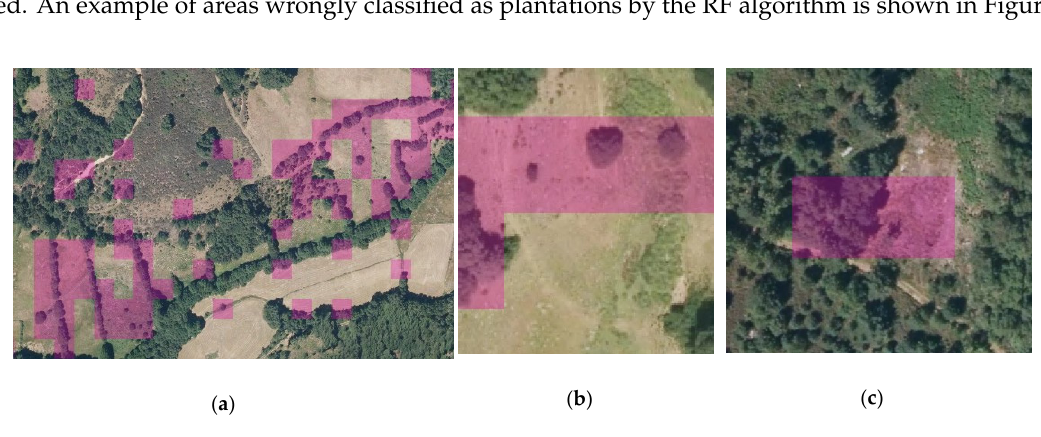
Figure 8. False positives in prediction model 2: ( a ) tree lines acting as boundaries between parcels; ( b ) isolated trees; ( c ) forests edges. Chestnut plantations are mapped in pink. Image source: PNOA image [56].